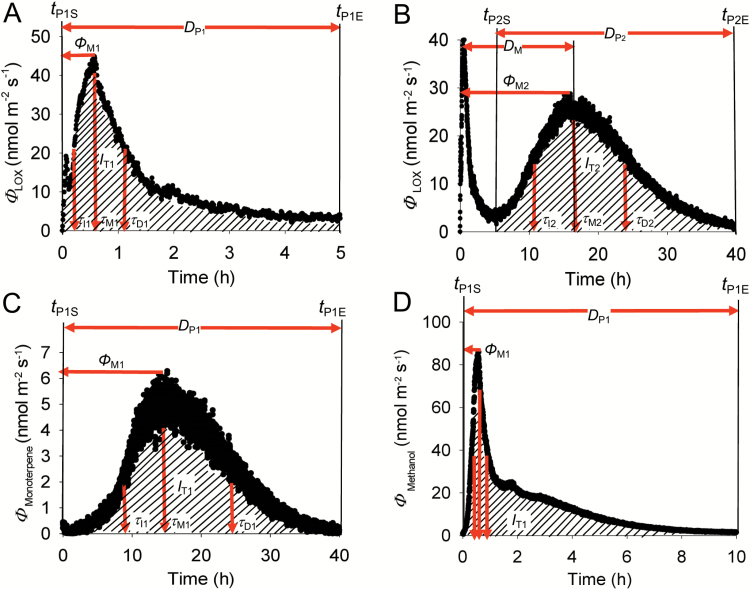
Representative time-courses of methyl jasmonate (MeJA)-induced emissions from a C. sativus leaf, and definition of key variables characterizing the induction response (see Table 1 for further specifics). Volatile emissions were induced by application of 20 mM MeJA that elicited an early lipoxygenase pathway volatile (LOX) burst (A), and a second late LOX emission burst (B) with concomitant monoterpene emission burst (C) and an early slowly decaying methanol emission burst (D). Shaded areas in all panels indicate integrated emissions corresponding to individual emission bursts (IT1 for the first and IT2 for the second burst, Equation 1), Φ
T1 and Φ
T2 correspond to the emission maxima for the two bursts, and tM1 and tM2 denote the corresponding times from the start of the treatment. Different τ-s stand for the initial doubling and decay times for the two bursts (Table 1). In (D), the red vertical arrows show the positions of
τ
I1, tM1, and
τ
D1 as in the other panels. After the leaf treatment with MeJA, the release of emissions was continuously monitored with a proton-transfer reaction time-of-flight mass spectrometer (PTR-TOF-MS). The time kinetics of sesquiterpene emission is analogous to monoterpene emissions and is therefore not presented.